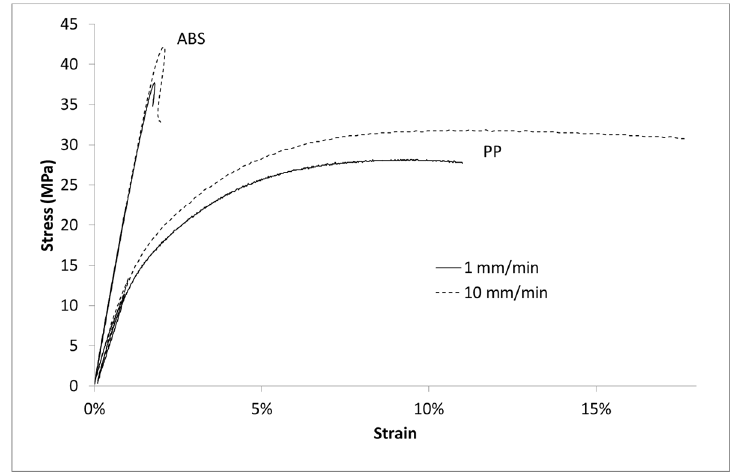
Figure 3. Stress vs. Lagrangian strain in uniaxial tensile tests at several imposed strain rates for ABS and PP.